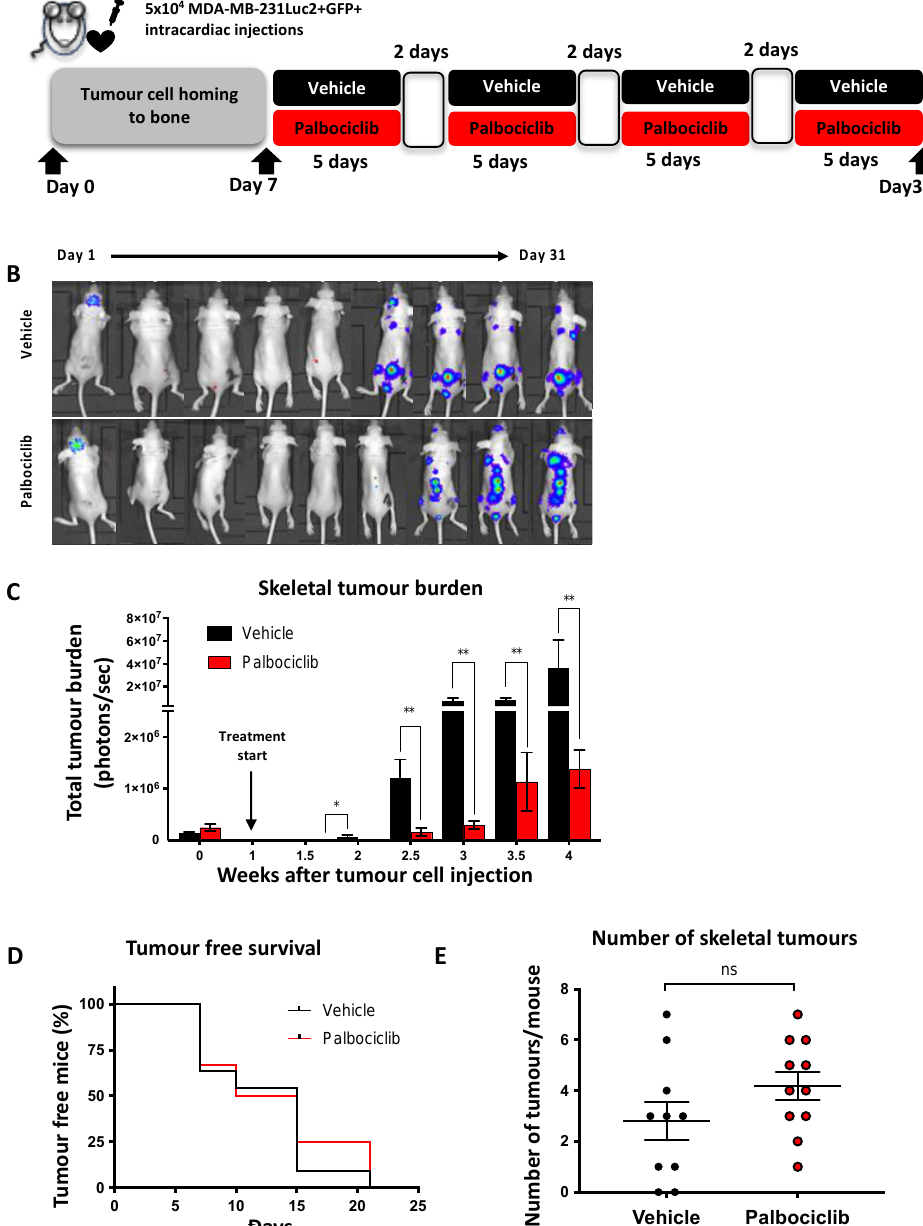
Figure 3. A 5-day-on/2-day-off palbociclib treatment reduces metastatic tumour burden in bone. ( A ) Schematic outline of the experiment investigating effects of a 5-day-on/2-day-off palbociclib treatment. Mice were injected with 5 × 10 4 MDA-MB-231Luc2+GFP+ cells via the intracardiac route. Treatment with 100 mg/kg palbociclib or vehicle commenced after 7 days and continued 5 days/week for 4 cycles. ( B ) Example of in vivo images demonstrating progression of skeletal tumours in both control and palbociclib treated animals. ( C ) Progression of skeletal tumour growth measured as tumour burden (photons/s) using in vivo live imaging (Mean ± SEM n = 10 (control) vs. n = 11 (palbociclib), * p < 0.05 ** p < 0.005). ( D ) Tumour-free mice throughout the duration of the study. ( E ) Number of tumours per mouse at day 35 (Mean ± SEM n = 10 (control) vs. n = 11 (palbociclib)). ns: not